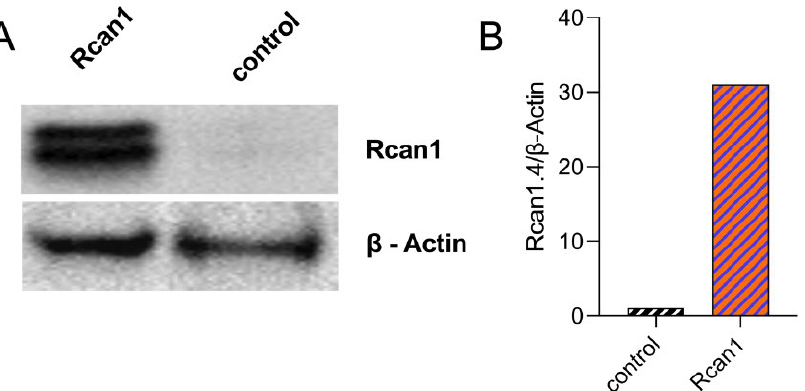
Figure 2. ( A , B ) Representative Western blot from two separate experiments showing overexpression of Rcan1 in LS8 cells, quantitated by ImageJ v.1.53j.